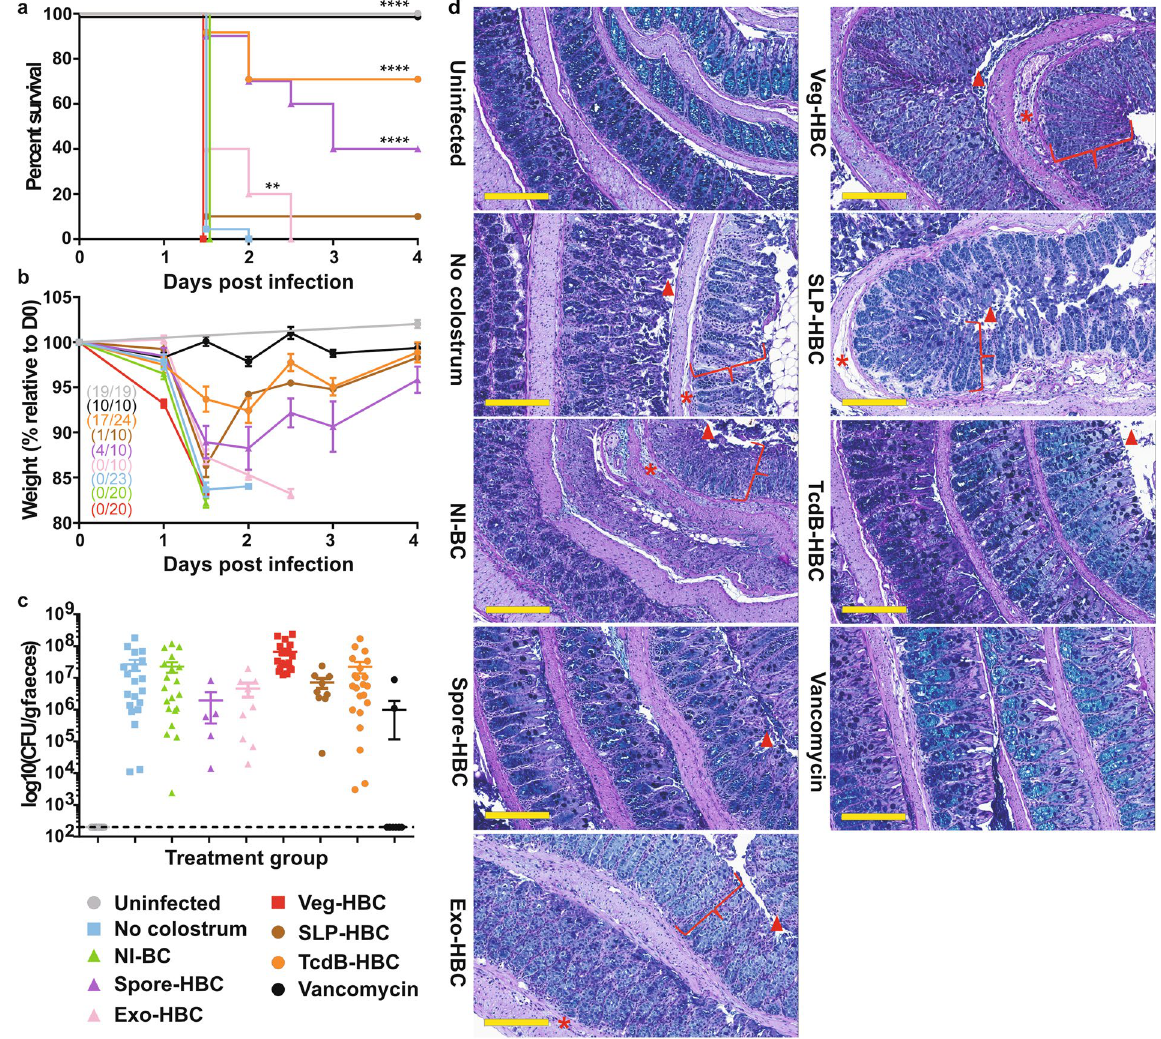
Figure 4. HBC-mediated prevention of C. difficile disease in mice. Mice were untreated or were pre-treated for two days with NI-BC, Spore-HBC, Exo-HBC, Veg-HBC, SLP-HBC, TcdB-HBC or vancomycin prior to infection with C. difficile spores. Colostrum or vancomycin was administered daily for the duration of the experiment. Uninfected, untreated mice served as controls. Mice were monitored daily for survival ( a ) and weight loss ( b ). Weight loss is presented as the % weight relative to the day of infection (day 0 or D0). Numbers in brackets indicate the number of surviving mice at the completion of the experiment compared to (/) the total number of mice at the beginning of the experiment. Faecal spore load was determined 24 hours post-infection and is presented as CFU/gram faeces (log 10 ), with each point representing a single mouse. The limit of detection is represented as a dotted line ( c ). Error bars represent the mean ± SEM of n = 10–24 mice. ** Indicates P < 0.01, **** Indicates P < 0.0001. Representative images of PAS/Alcian blue stained colonic (d) tissue from mice. Square brackets ([) indicate crypt hyperplasia, arrow heads ( ▲ ) represent epithelial damage and asterisks ( * ) represent oedema and inflammation. Scale bars represent 200 µ